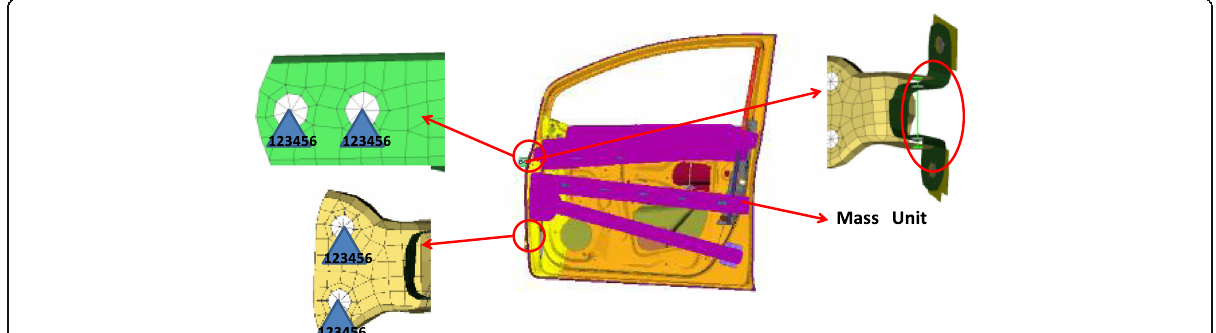
Fig. 5 Counterweight of the car door assembly with mass